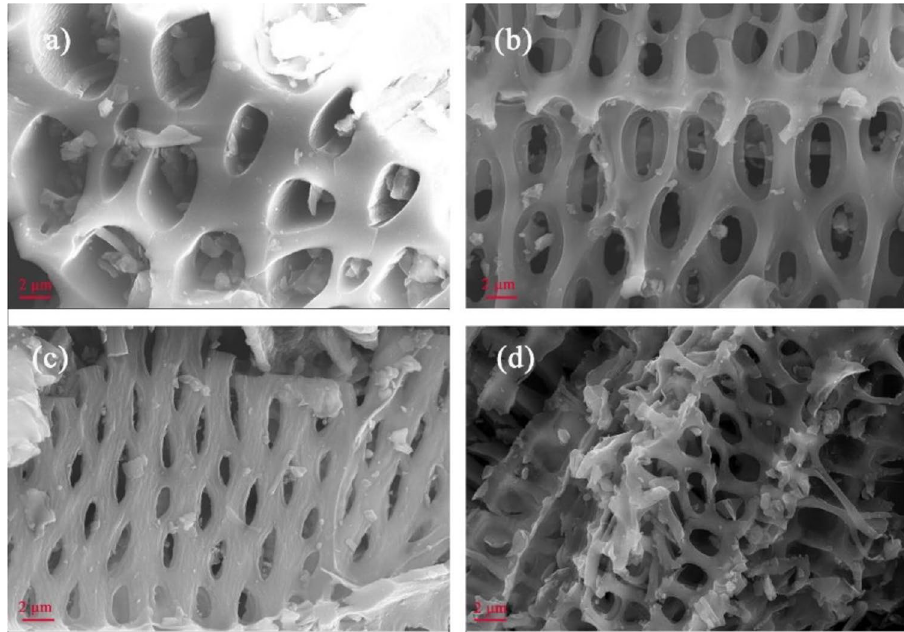
Figure 3. SEM (ZEISS) images of biochar at different pyrolysis temperatures: ( a ) C1, ( b ) C8, ( c ) C12, and ( d )